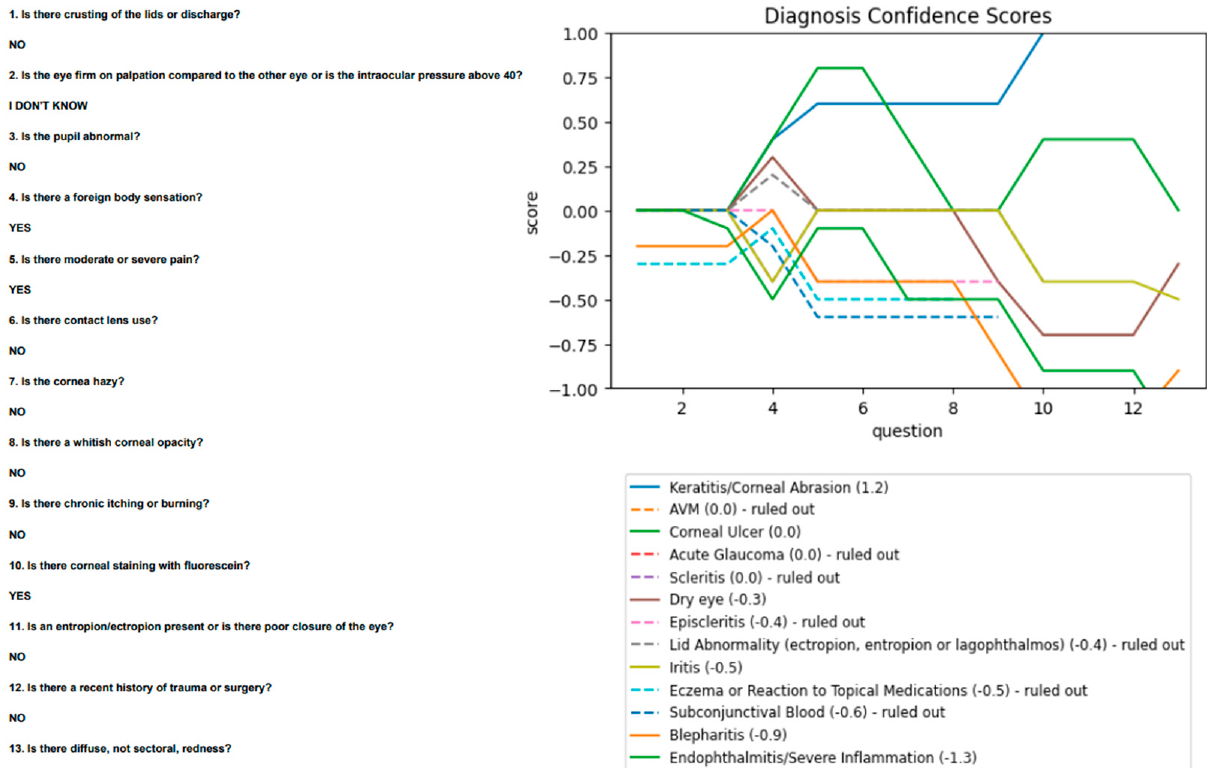
Figure 5. “Scleritis” case, using data from referrers. Ophthalmology agreed with most findings but did not note staining. The algorithm was re-run with this change and proposed scleritis as its second diagnosis, after keratitis (Figure